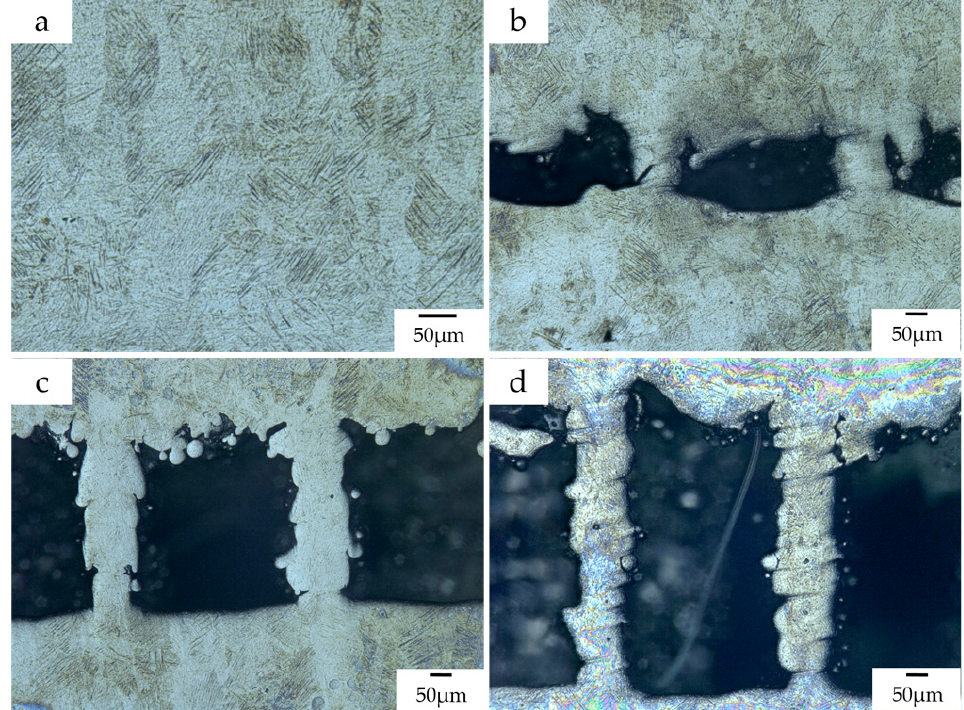
Figure 10. ( a ) The microstructure of the main body of the tensile specimens; the microstructures of the support teeth of the tensile specimens whose designed gap is ( b ) 0.24 mm, ( c ) 0.48 mm, and ( d ) 0.72 mm.